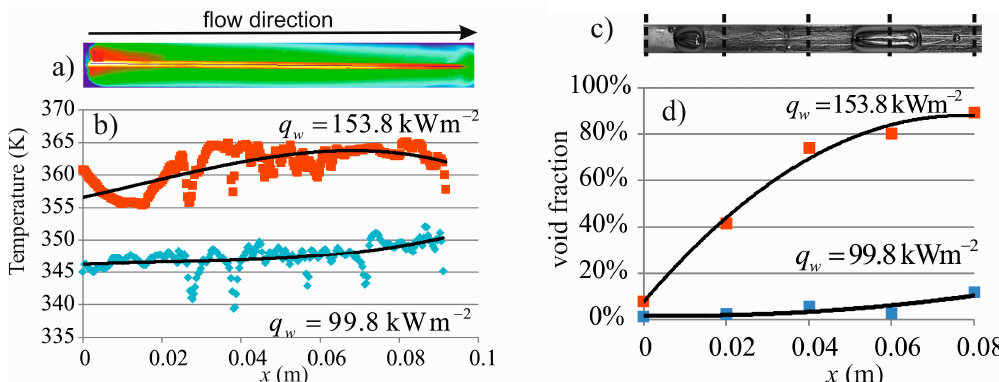
Figure 7. ( a ) The thermogram example image; ( b ) the foil surface temperature field from the IR camera FLIR SC 7600 (FLIR Systems, Wilsonville, OR, USA) approximated using a third degree polynomial; ( c ) the flow structures; ( d ) the void fraction for q w = 99.8 kW m − 2 and q w = 153.8 kW m − 2 . Energies 2018 , 11 , x FOR PEER REVIEW Numerical calculations were made for the following experimental data: an inlet pressure 1.1 kPa (average), a liquid temperature at the inlet 308 K (average), a mass flow 21 kg m − 2 s − 1 , and six heat